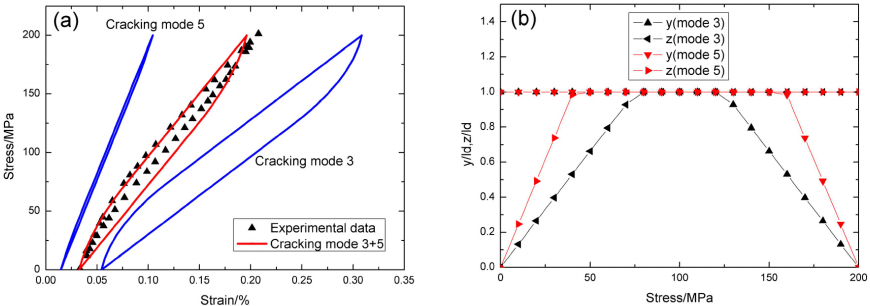
Figure 8. ( a ) The theoretical and experimental hysteresis loops; and ( b ) the interface slip lengths, i.e. , y / l d and z / l d , of matrix cracking mode 3 and mode 5 of cross-ply C/SiC composite when σ max = 200